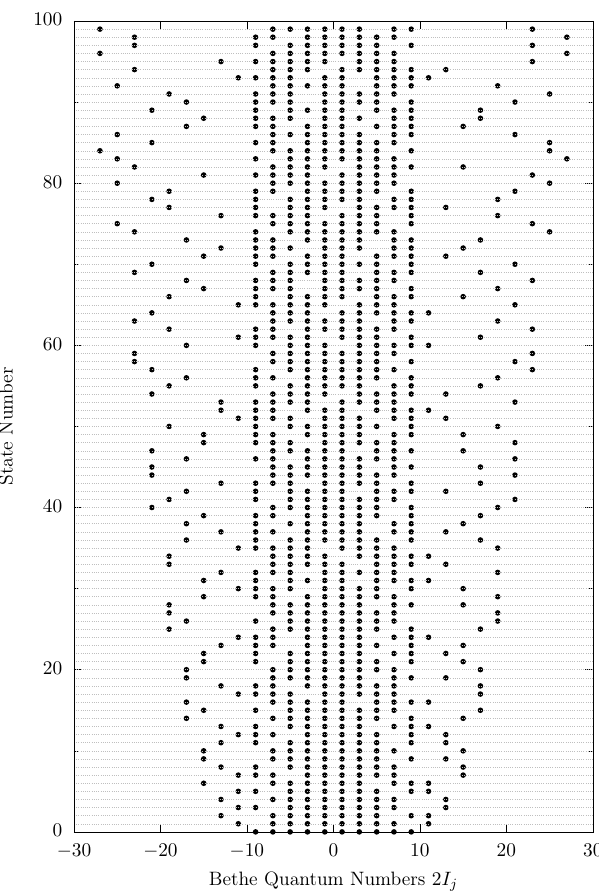
} , see Eq. (9), characterizing Figure 6: The configurations of quantum numbers { I j = 20 ground state the 100 computational basis states with highest overlaps in the c i = 10 eigenstates. These were obtained from a numerical constructed in terms of c f renormalization group procedure with the basis ordered according to the metric